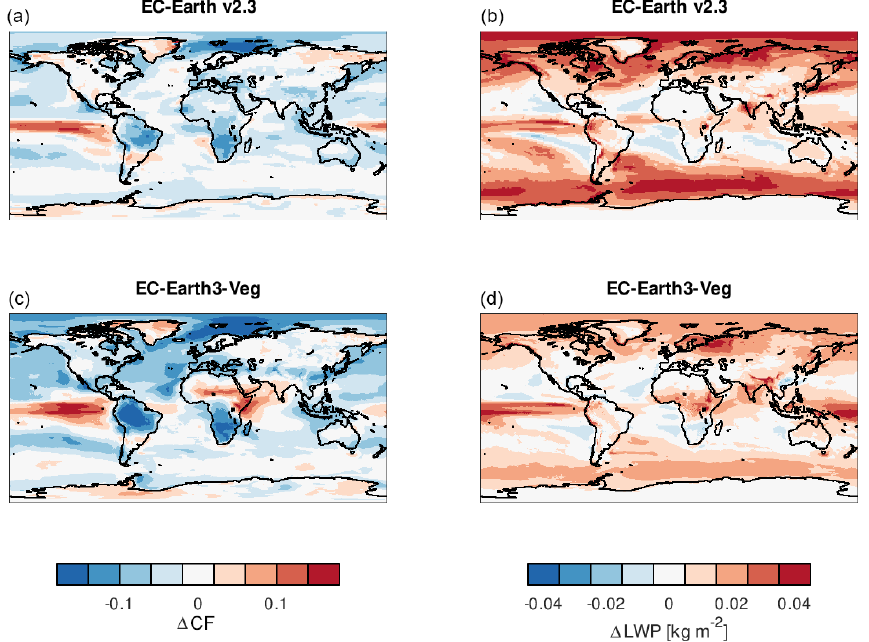
Figure 2. Response of cloud fraction (a, c) and the cloud liquid water path (LWP) (b, d) to a quadrupling of CO 2 in ECE2 (a, b) and ECE3 (c, d) .